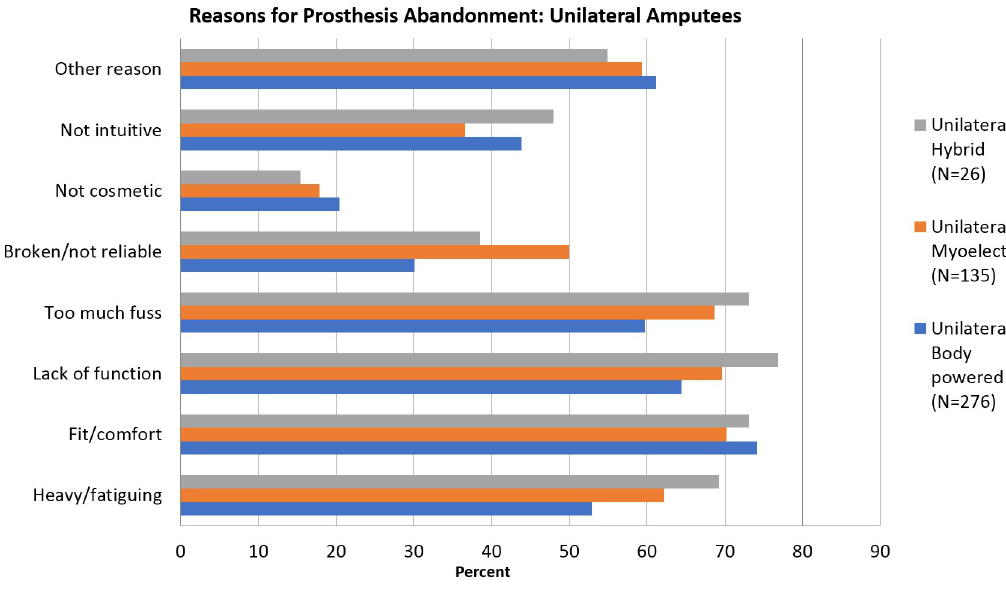
Fig 2. Reasons for prosthesis abandonment by type of device: Unilateral amputees.